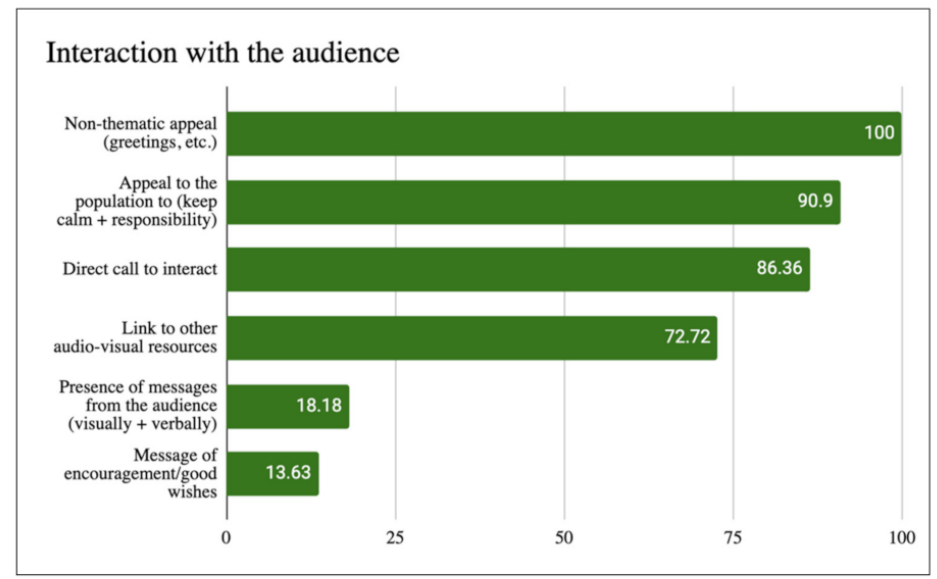
Figure 3. Interaction with the audience in